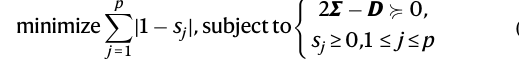
Fig. 5 | Phenome-wide Analysis of 1403 binary phenotypes from UK biobank disease category. E For loci identi fi ed by both conventional GWAS and the pro- data with 408,961 white British participants with European ancestry. posed method, we present median and 25%/75% quantiles of the number of iden- A , B Comparison between conventional GWAS and GhostKnockoff. C Summary of ti fi ed variants per locus. For visualization purposes, we present the results for ( A )and ( B ).For each phenotype, wecalculated the ratio between the totalnumber disease phenotypes with ≥ 5 loci identi fi ed by either conventional GWAS or of identi fi ed loci/ the average number of proxy variants per shared locus by GhostKnockoffandbyconventionalGWAS(cappedat500forbettervisualization). Panel( C )presentstheaverageratio(asin( A )and( B ))across1403phenotypes.The p . D Distribution of the num- standard error is calculated as standarddeviationoftheratio ffiffiffiffiffiffiffiffiffiffiffiffiffiffiffiffiffiffiffiffiffiffiffiffiffiffiffiffiffiffiffiffiffiffiffiffiffiffiffiffiffiffiffiffiffiffi totalnumberofphenotypes (cid:2) 1 berofidenti fi edloci. Wepresent boxplot (median and 25%/75%quantiles) for each